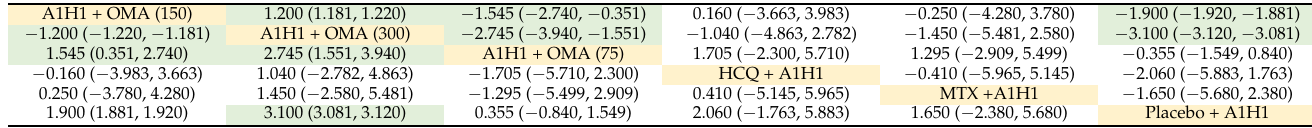
Table 2. League table of the Dermatology Life Quality Index (DLQI)